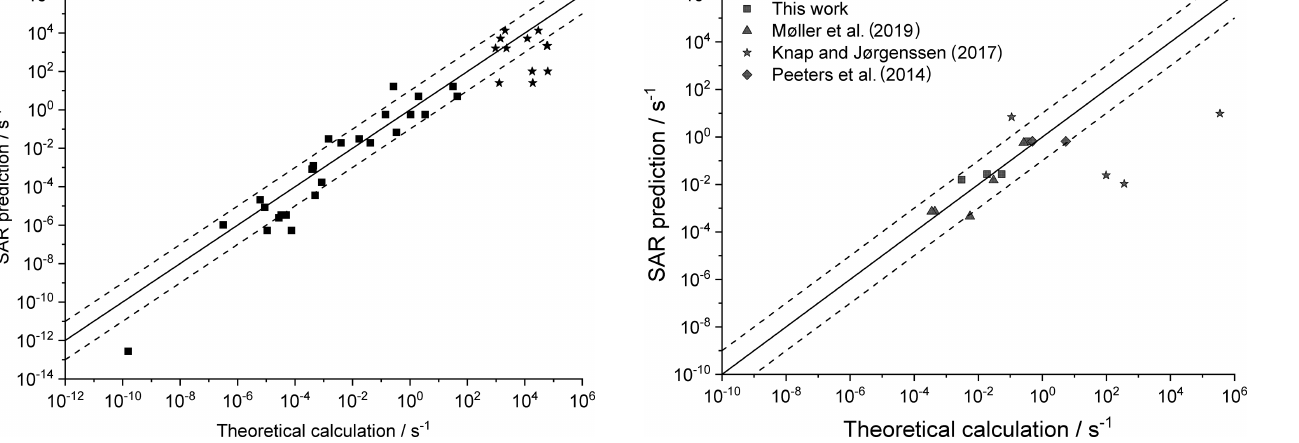
Figure 4. k (298K) H migration in multi-functionalized species with spectator substituents. The data shown are derived in this work or our earlier publications, using MC-TST incorporating all conform- ers compared against the SAR prediction. The stars indicate OOH/ (cid:113) OO H-scrambling reactions. The solid line shows 1 : 1 correspon- dence, with the dotted lines delineating an order of magnitude of uncertainty.